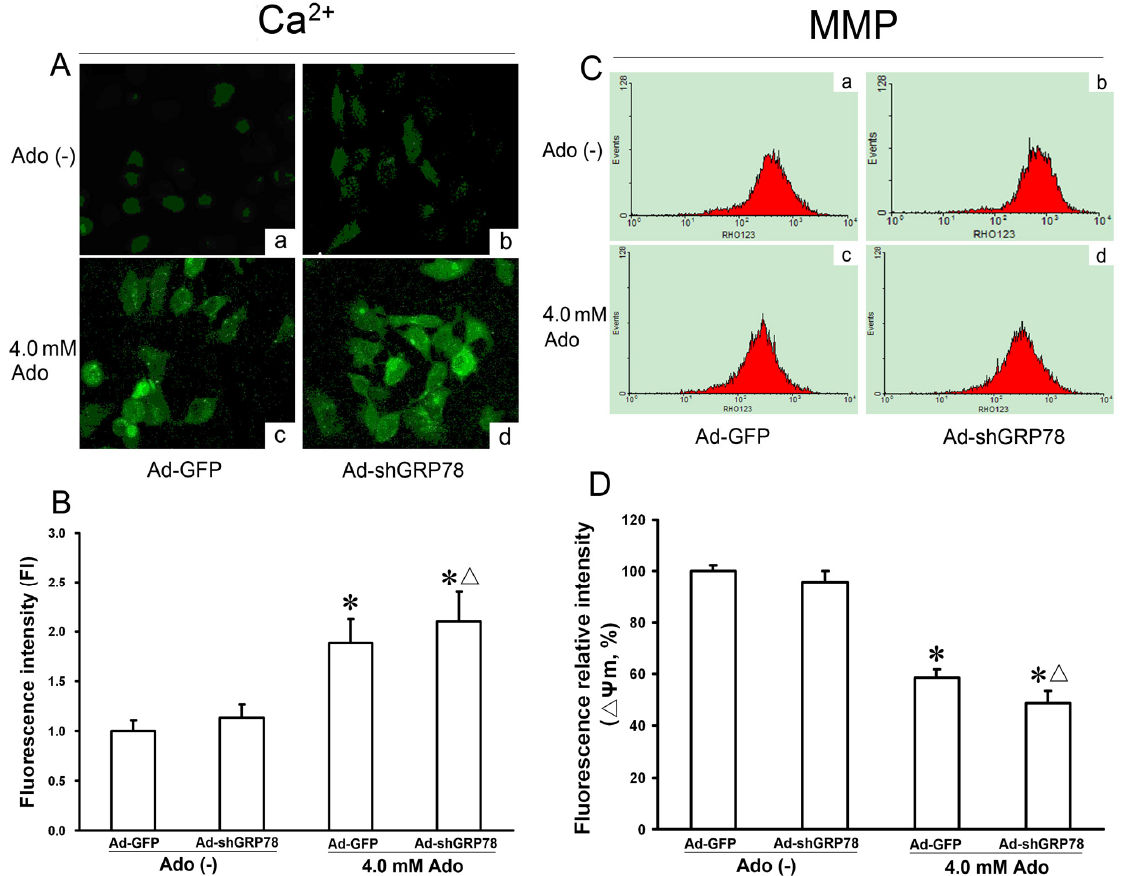
Figure 5. Effects of GRP78 knockdown on Ca 2+ concentration and mitochondrial membrane potentials ( ΔΨ m) in adenosine-treated HepG2 cells. HepG2 cells were transfected with either Ad-GFP (control) or Ad-shGRP78. After incubation for 24 h, cells were incubated with or without 4.0 mmol/L adenosine for a further 24 h. Fluo-3/AM fluorescence and laser scanning confocal microscopy (LSCM) were utilized to measure cytosolic Ca 2+ . The relative fluorescence intensity values represent cytosolic Ca 2+ content ( A ); ΔΨ m was measured by flow cytometry ( C ); Adenosine caused a significant increase of [Ca 2+ ]i and loss of ΔΨ m; GRP78 knockdown further worsened the Ca 2+ overload and loss of ΔΨ m; and ( B , D ) Data are presented as means ± SD of at least three independents experiments. * p < 0.05, vs. the negative control group. Δ p < 0.05, vs. the positive control